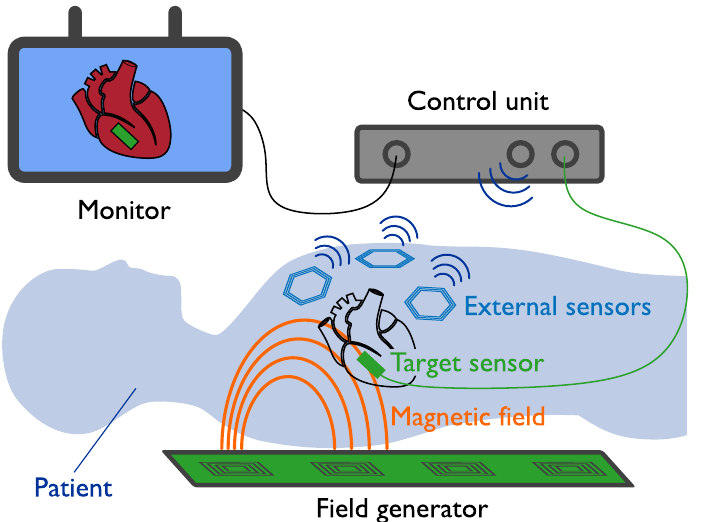
Figure 2. In electromagnetic tracking, a target sensor, attached to the instrument tip, measures the magnetic field generated by a set of transmitter coils. The signal is analysed by a control unit, which recovers sensor position and orientation from a known magnetic field model. The instrument is then visualised on an external monitor to assist the surgical operation. The use of external redundant sensors can help compensate for patient motion and magnetic field